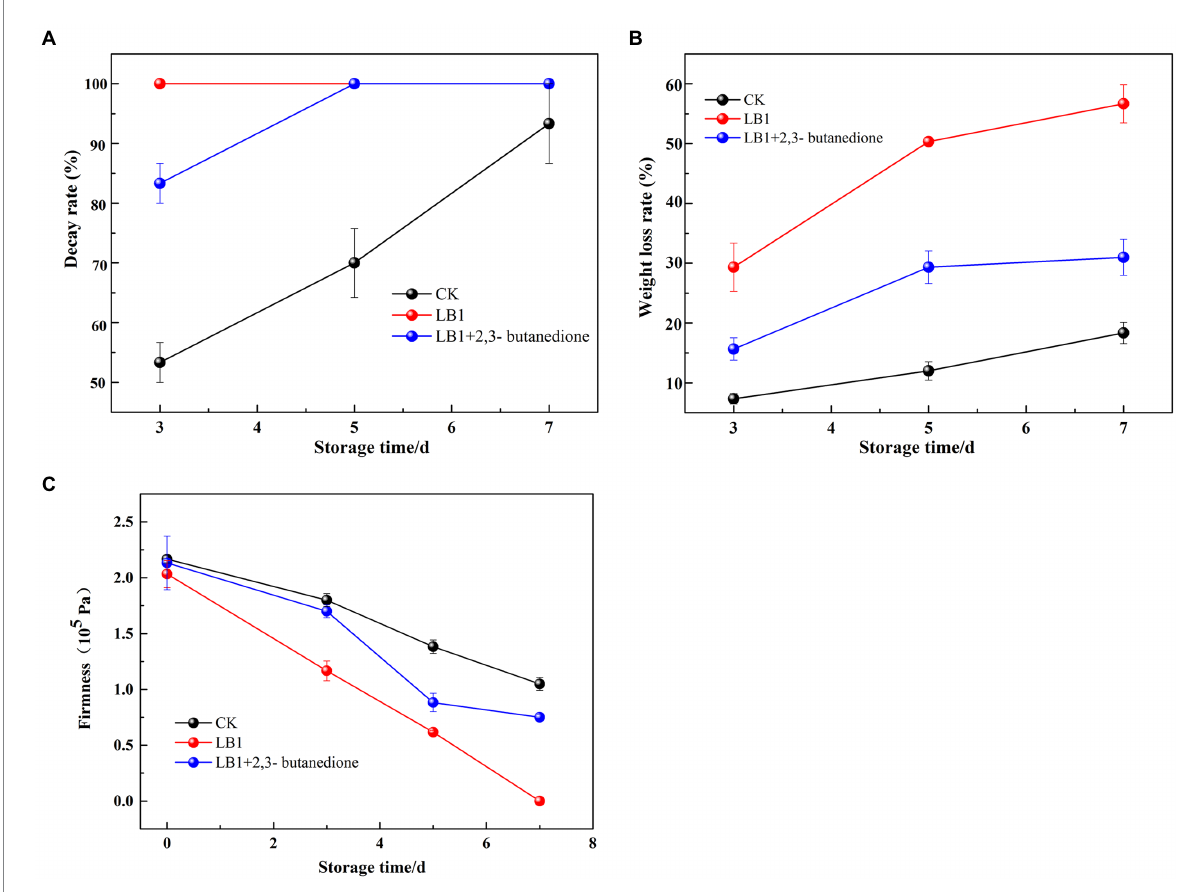
FIGURE 5 Determination of Decay weight, weight loss and firmness of wolfberry fruit after harvest ( A : Decay weight, B : weight loss, C :